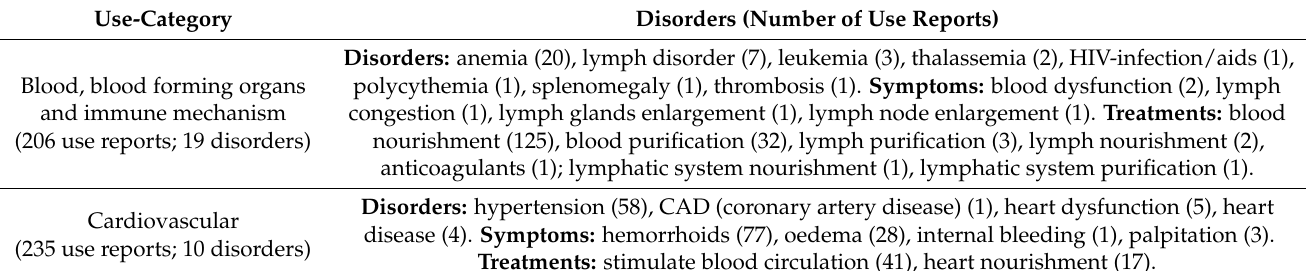
Table 1. Categories of disorders, treatments and symptoms related to medicinal legume species in Thailand, derived from 152 primary sources produced from